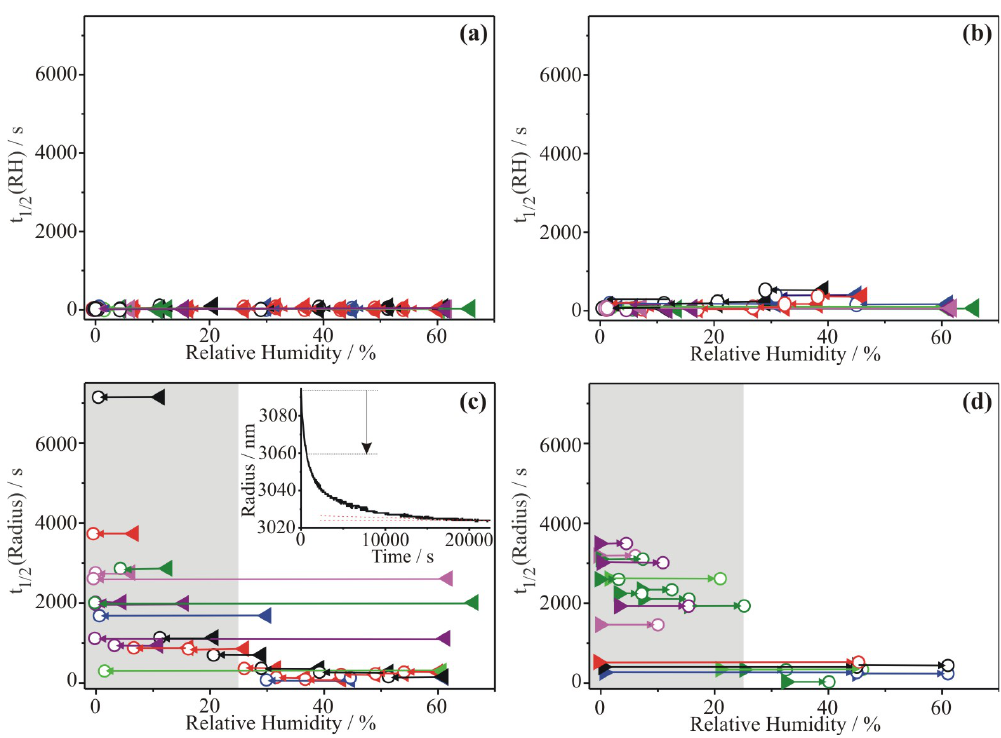
Fig. 7. The recorded half-time for the RH decrease before (a) and after (b) the trapping cell. The filled triangles denote the initial RH and the open circles the final RH with different colours corresponding to measurements on different droplets. (c) The half-time estimated for the change in sucrose droplet radius for a series of dehumidifying measurements on different droplets (different colours). The grey shaded area indicates the RH region which is considered to lie below the glass transition. The inset is an example of a typical size measurement. After 10000s, the rate of decrease in size becomes less than 1nm in 10000s, as illustrated by the red dotted line. The time for the droplet to reach the half way point in progressing to this slowly evolving size provides a measure of the change in the rate of mass transfer below the glass transition. (d) The half-time for increase in radius of sucrose droplets during a humidifying